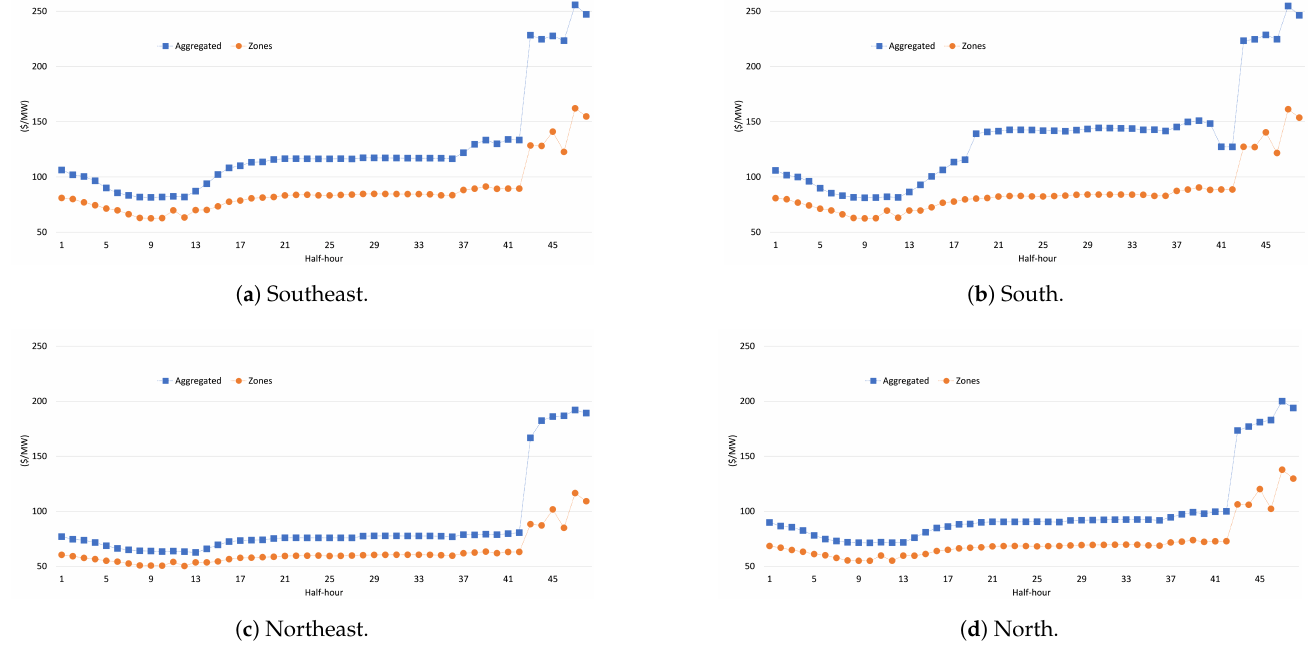
Figure 17. Subsystem marginal costs for Case 8 Trial 1. ( a ) Southeast; ( b ) South; ( c ) Northeast; ( d ) North.